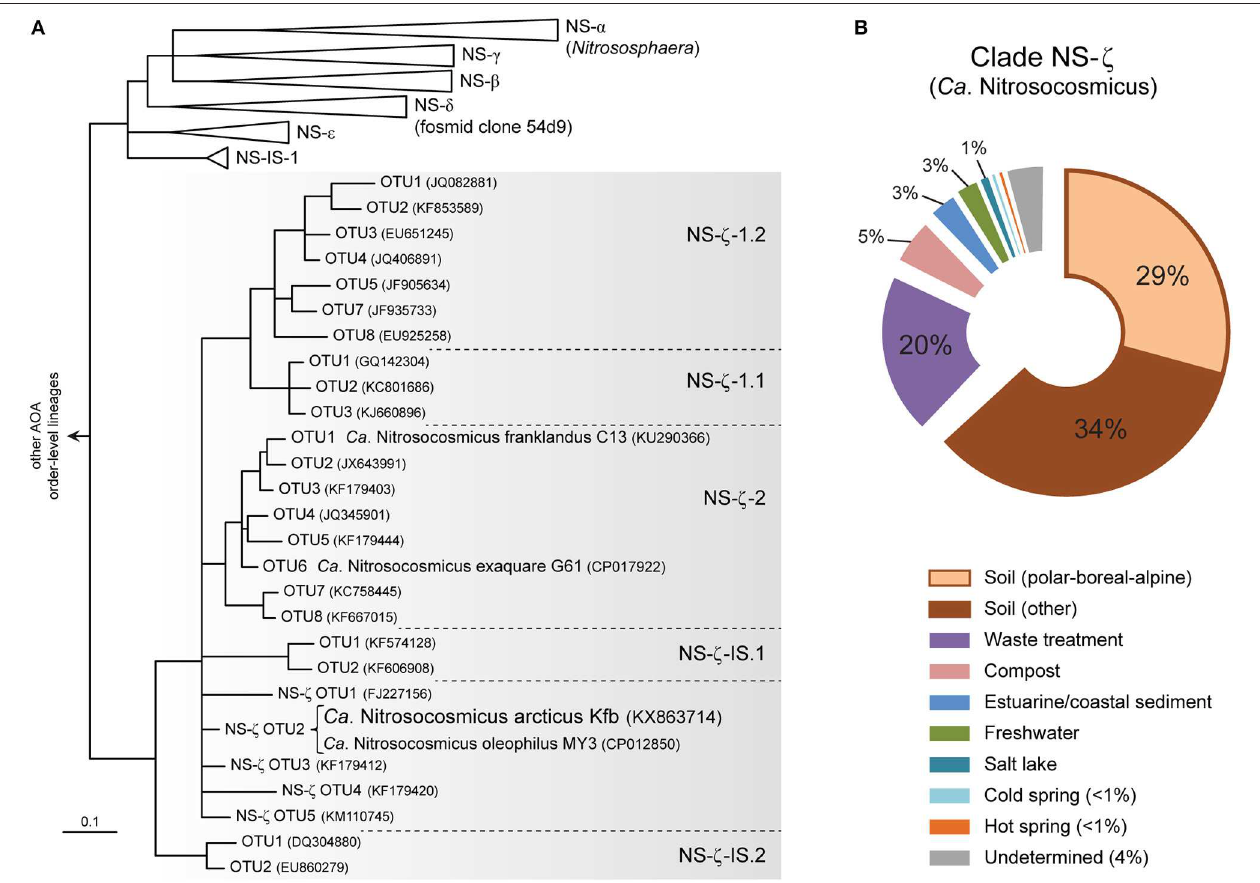
FIGURE 4 | Phylogeny and environmental distribution of AOA clade NS- ζ (Zeta), representing the candidate genus Nitrosocosmicus based on amoA genes. (A) Tree showing the amoA gene diversity within clade NS- ζ and the phylogenetic placement of Ca. N. arcticus Kfb and other cultivated Ca . Nitrosocosmicus species. Only the order-level amoA lineage NS ( Nitrososphaerales) is shown, [adapted from the publicly-available reference phylogeny by Alves et al. (2018)]. Organisms and OTUs not associated with a specific subclade are classified as a basal NS- ζ OTU (e.g., Ca. N. arcticus Kfb is classified as NS- ζ -OTU2). All branches are highly supported and OTUs defined at 96% sequence identity (Alves et al., 2018). (B) Global environmental distribution of clade NS- ζ based on 364 amoA genes in the curated database (Alves et al., 2018). Sequences from polar, boreal and alpine soils and from cold springs were further categorized here.